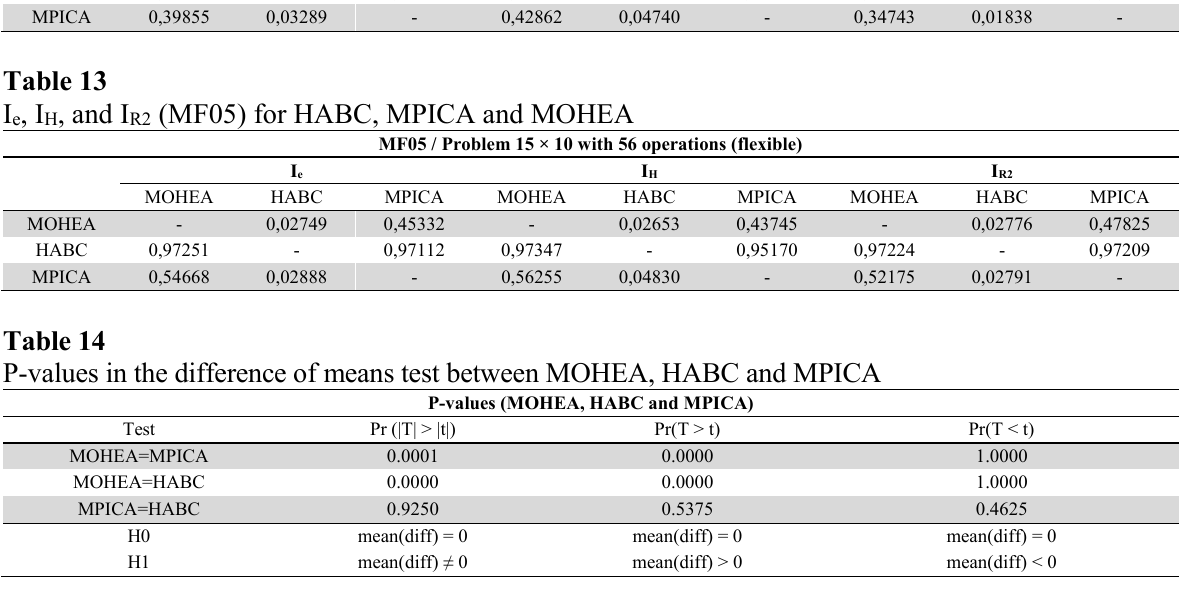
Mean Running Time for MOHEA, HABC and MPICA